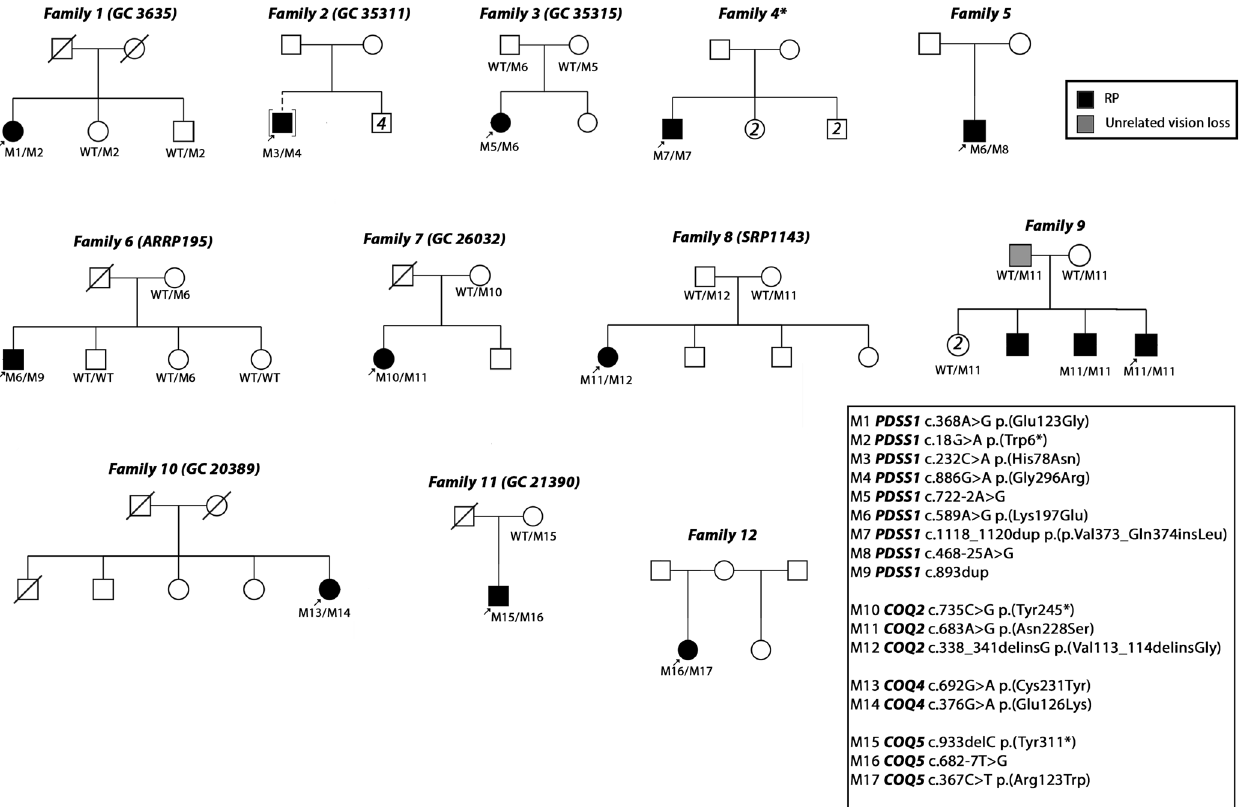
Fig. 1 Pedigrees of families and identi fi ed candidate pathogenic variants in CoQ10 biosynthesis pathway genes. An arrow indicates the proband. Shaded symbols represent affected individuals. Different shading in family 9 indicates unrelated vision loss (not retinopathy). M – mutant, WT –